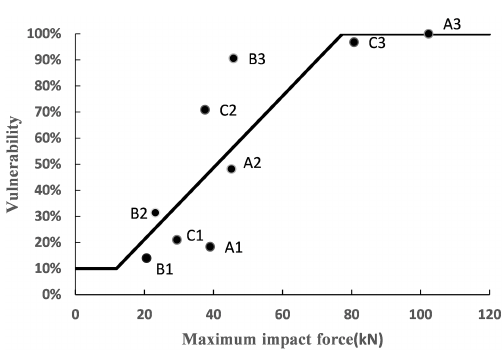
Figure 6. Vulnerability scatter chart with momentum.